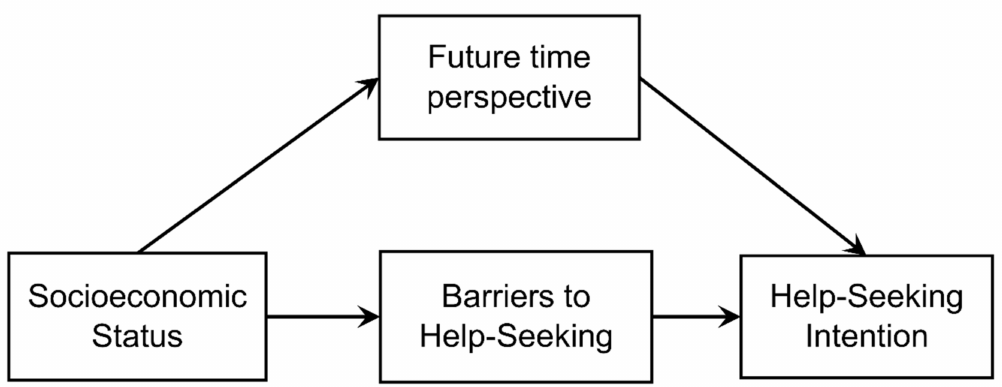
Figure 1. Hypothesis model for help-seeking behavior among middle-aged and older